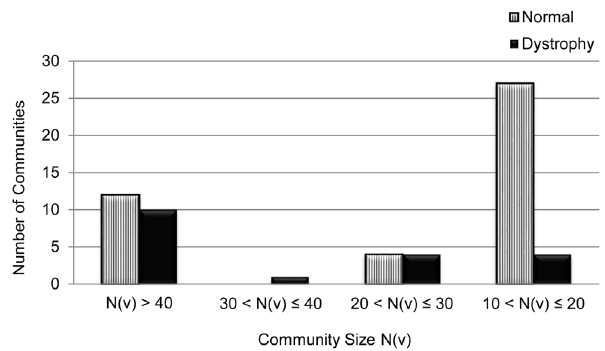
Figure 2. Distribution of Communities. A comparison of the distribution of communities in both the Normal and DMD networks, obtained using the Newman and Girvan’s edge-betweenness algorithm. The green bars show the distribution of the total number of 644 communities obtained from the Normal network, across the four bins of community size, and the red bars represent the distribution of the 283